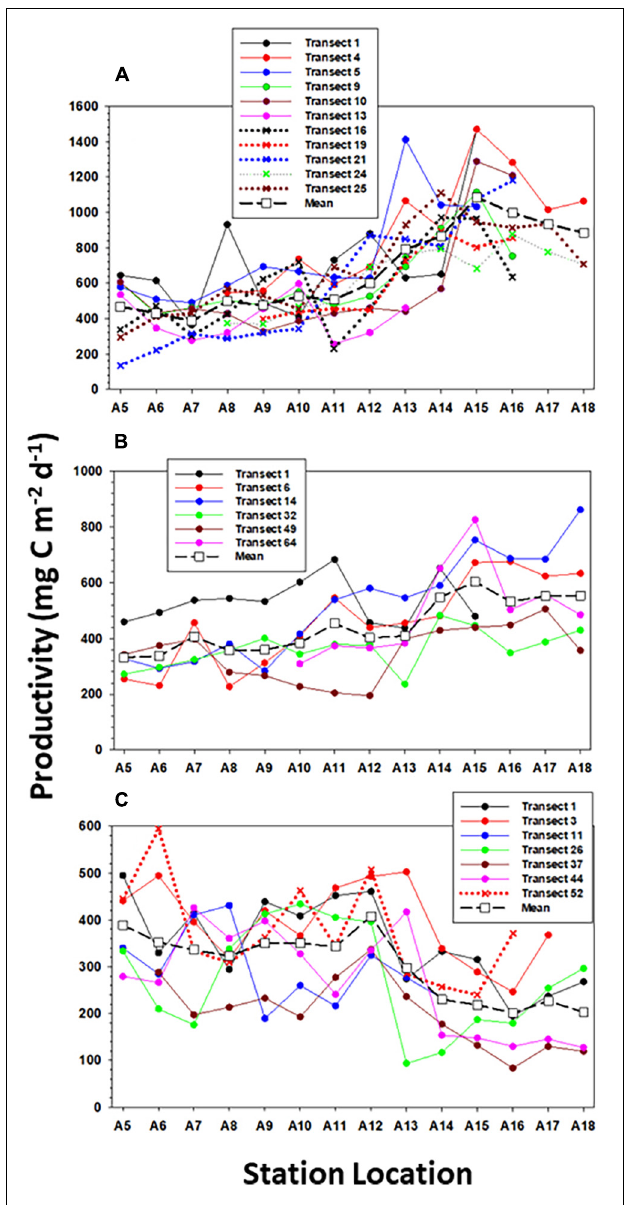
FIGURE 7 | The distribution of primary productivity determined by the vertically resolved productivity model along all transects occupied within (A) AR29, (B) RB1904, and (C)